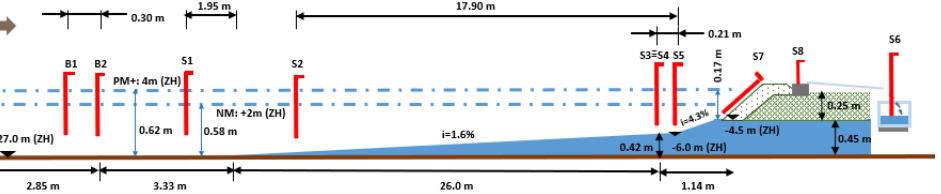
Figure 3. Bottom and cross ‐ section of the quay section of Ericeira’s breakwater tested in the scale ‐ model tests. Layout of the resistive wave probes along the flume.